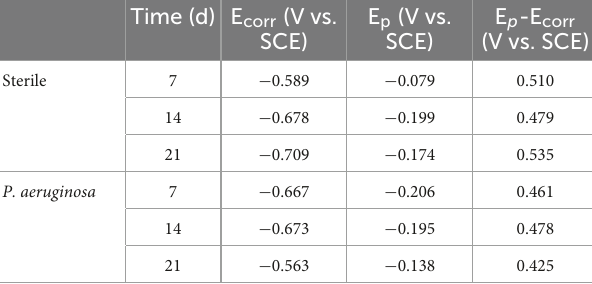
TABLE 2 Open-circuit potential (OCP) and pitting potential obtained after the anodic polarization curve test. Time (d) E corr (V vs. E p (V vs. E p -E corr SCE) SCE) (V vs. SCE)